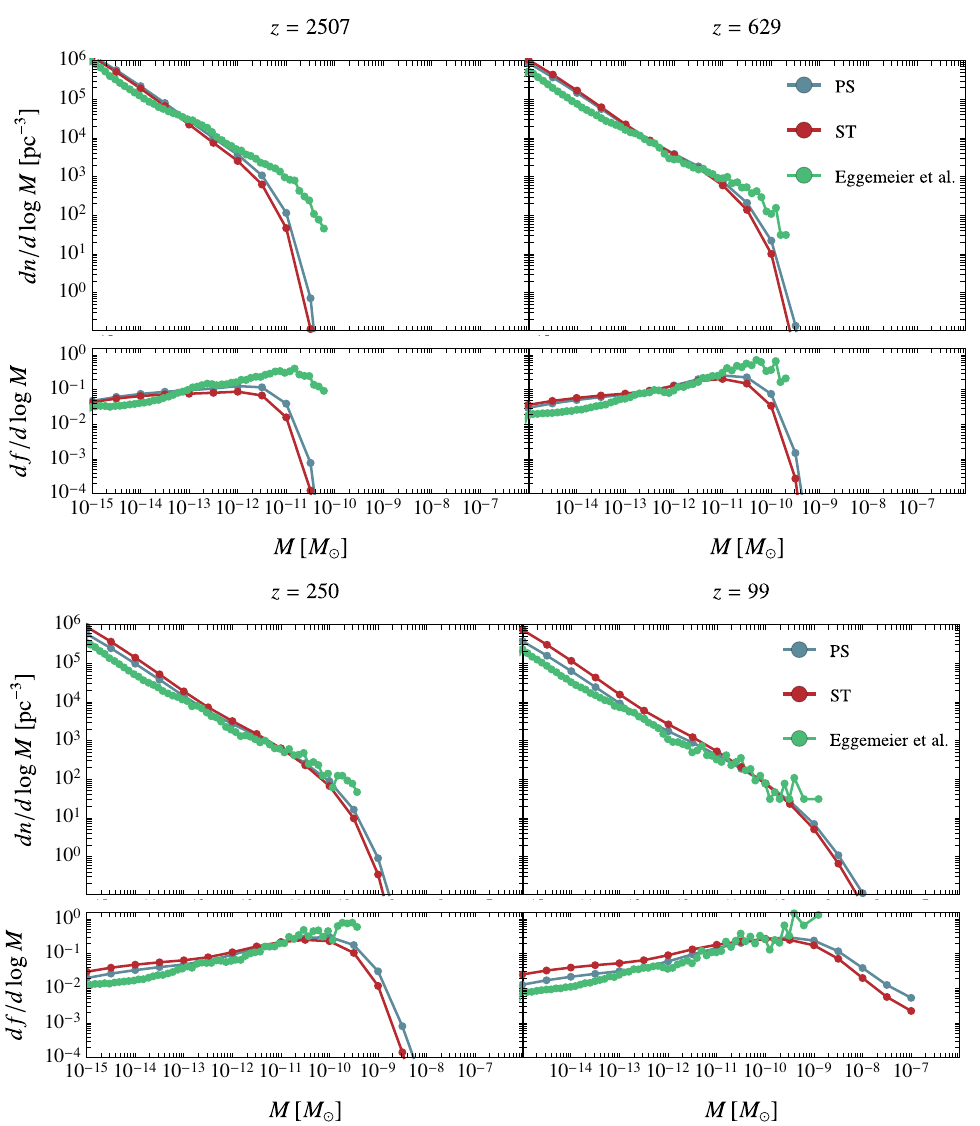
Figure 11 . Comparison between the HMF predicted by PS (blue) and the results of the numerical simulations (green) at four different redshifts. For comparison we also show the predictions of another analytical prescription (red) developed by Sheth &